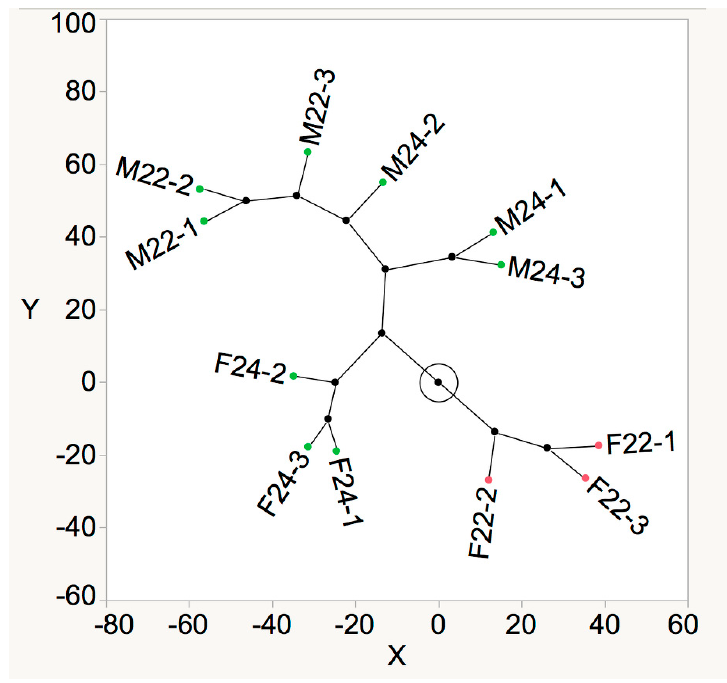
Figure 3. A constellation plot showing similarities in aroma compounds in Marquette and Frontenac wines produced from berries harvested at 22° and 24° Brix. The wine samples are arranged as endpoints and each cluster joins as a new point, with lines drawn representing membership. The longer the line, the greater the difference.